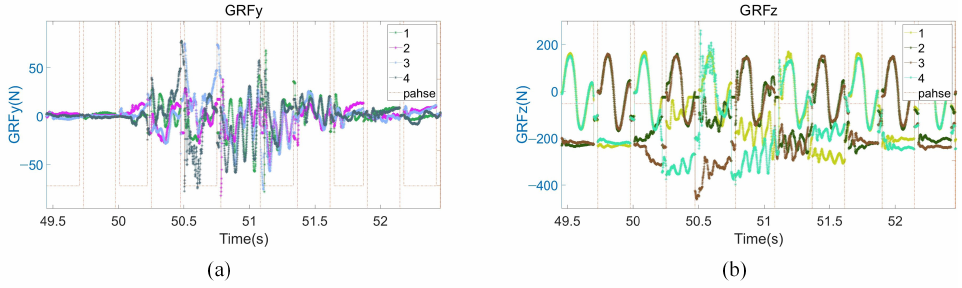
Figure 8. Disturbance recovery experiment data. ( a ) GRF in the y-direction; ( b ) GRF in the z-direction.